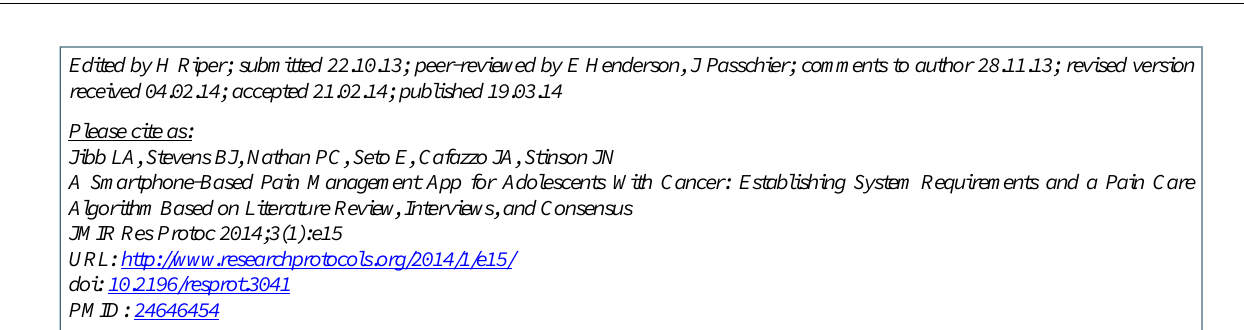
A Smartphone-Based Pain Management App for Adolescents With Cancer: Establishing System Requirements and a Pain Care Algorithm Based on Literature Review, Interviews, and